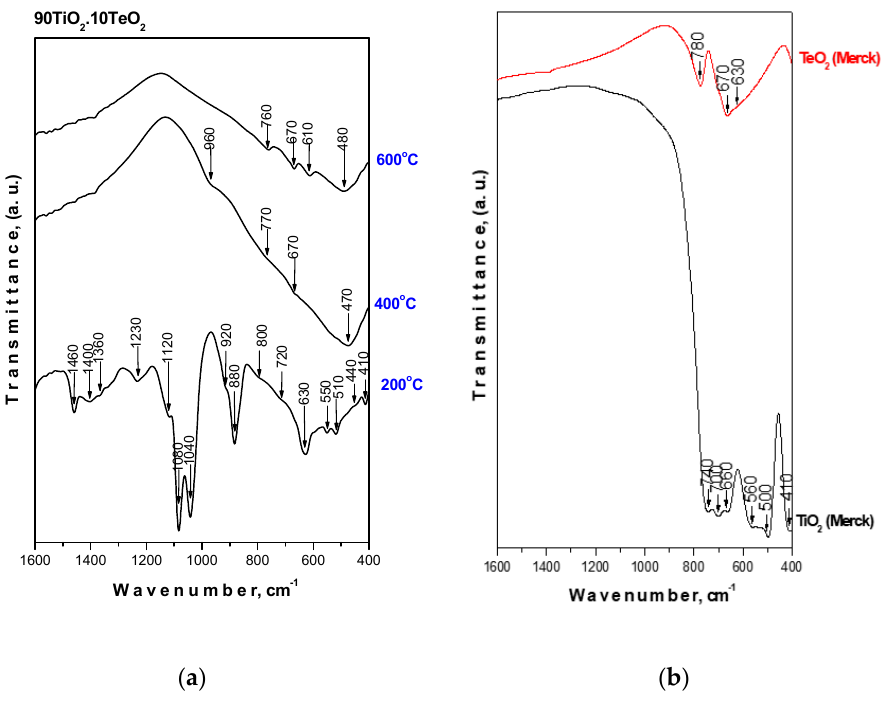
Figure 3. IR spectra of: ( a ) investigated sample heat treated at different temperatures and ( b ) TeO 2 and TiO 2 commercial products.